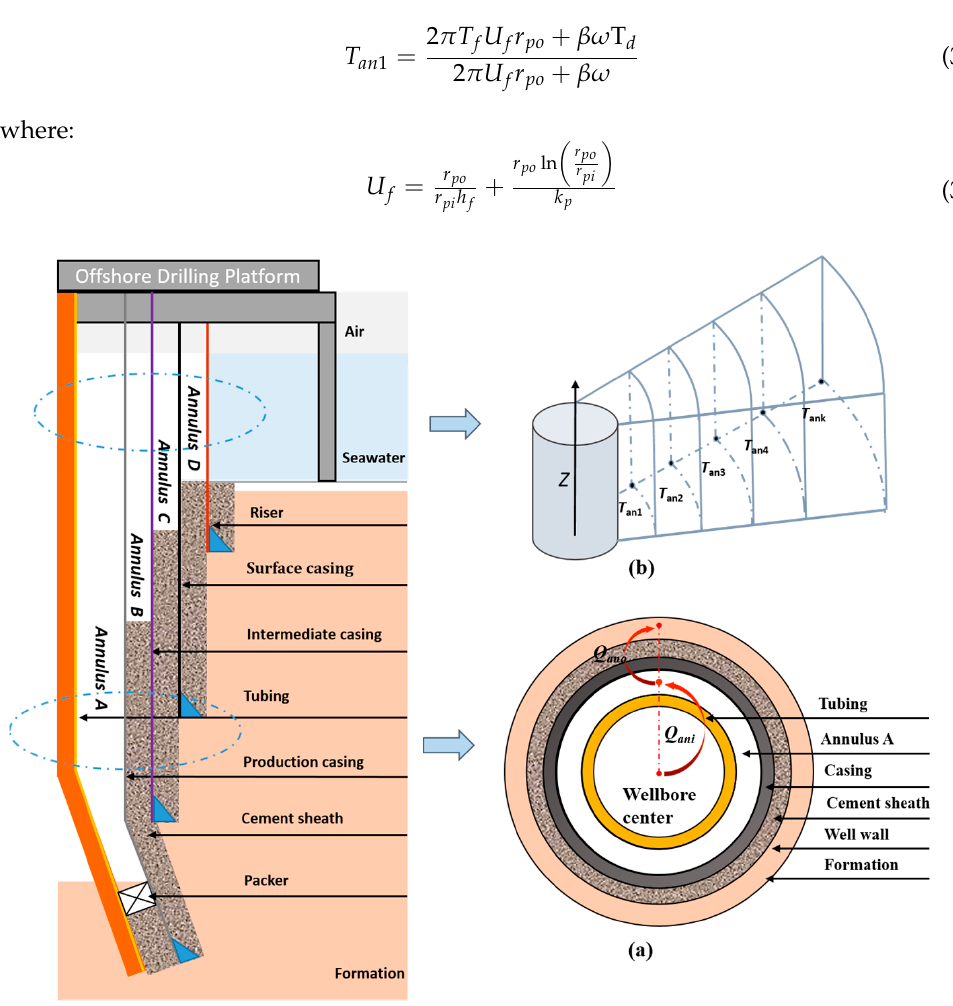
Figure 3. Schematic of multiple annulus heat transfer. ( a ) Schematic of single annulus heat transfer. ( b ) Schematic of multiple annulus heat transfer.